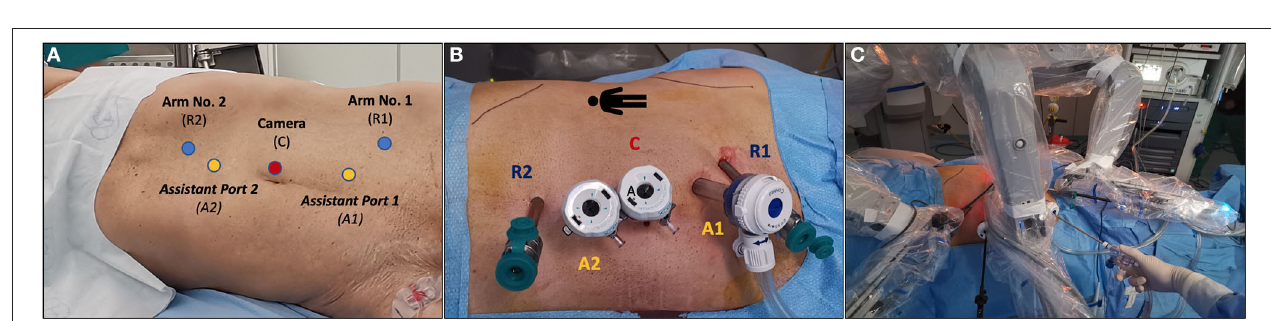
FIGURE 3 | Overview of port placement in our case of robot-assisted partial nephrectomy (RAPN) for two complex renal masses in a patient with a horseshoe kidney. The da Vinci Si robotic platform with a 30 ◦ lens, a three-arm configuration plus two assistant ports [both 12-mm ports, of which one for the AirSeal ® system (SurgiQuest, ConMed Corporation, Milford, CT)] was adopted. (A) Placement of the camera port using the Hasson technique plus two robotic ports and two 12-mm assistant ports. (B) Overview of the final port placement. (C) Docking of the robot. (e) double-layer and single-layer renorrhaphy for renal reconstruction of the larger and smaller renal mass, respectively (6,